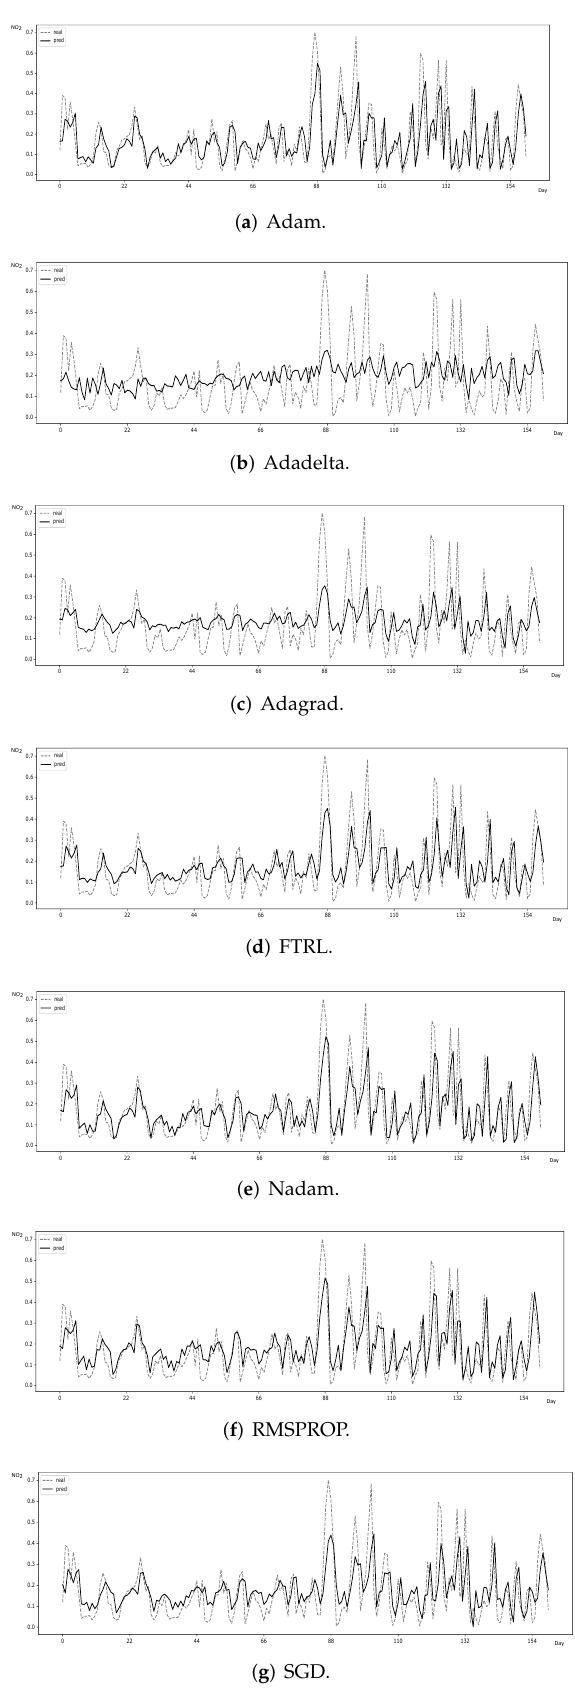
Figure 21. Predicted vs. actual normalized output values with changes in the selected